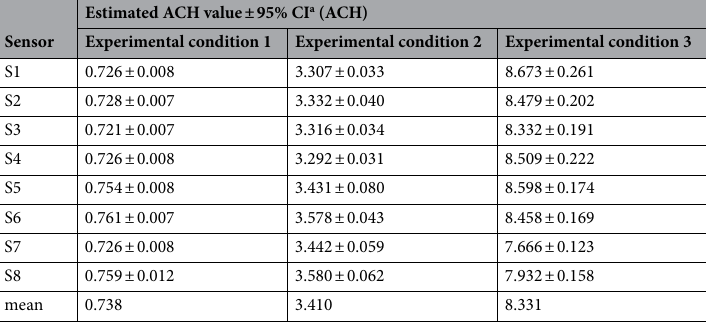
Table 2. Estimated air changes per hour (ACH) value per sensor. a CI: confidence